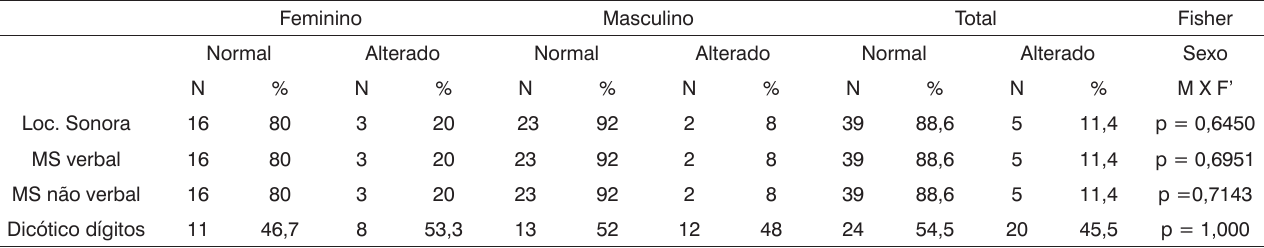
Tabela 4. Crianças fissuradas, do sexo masculino e feminino, consideradas normais e alteradas, quantos aos testes da Triagem do Processa- mento Auditivo.